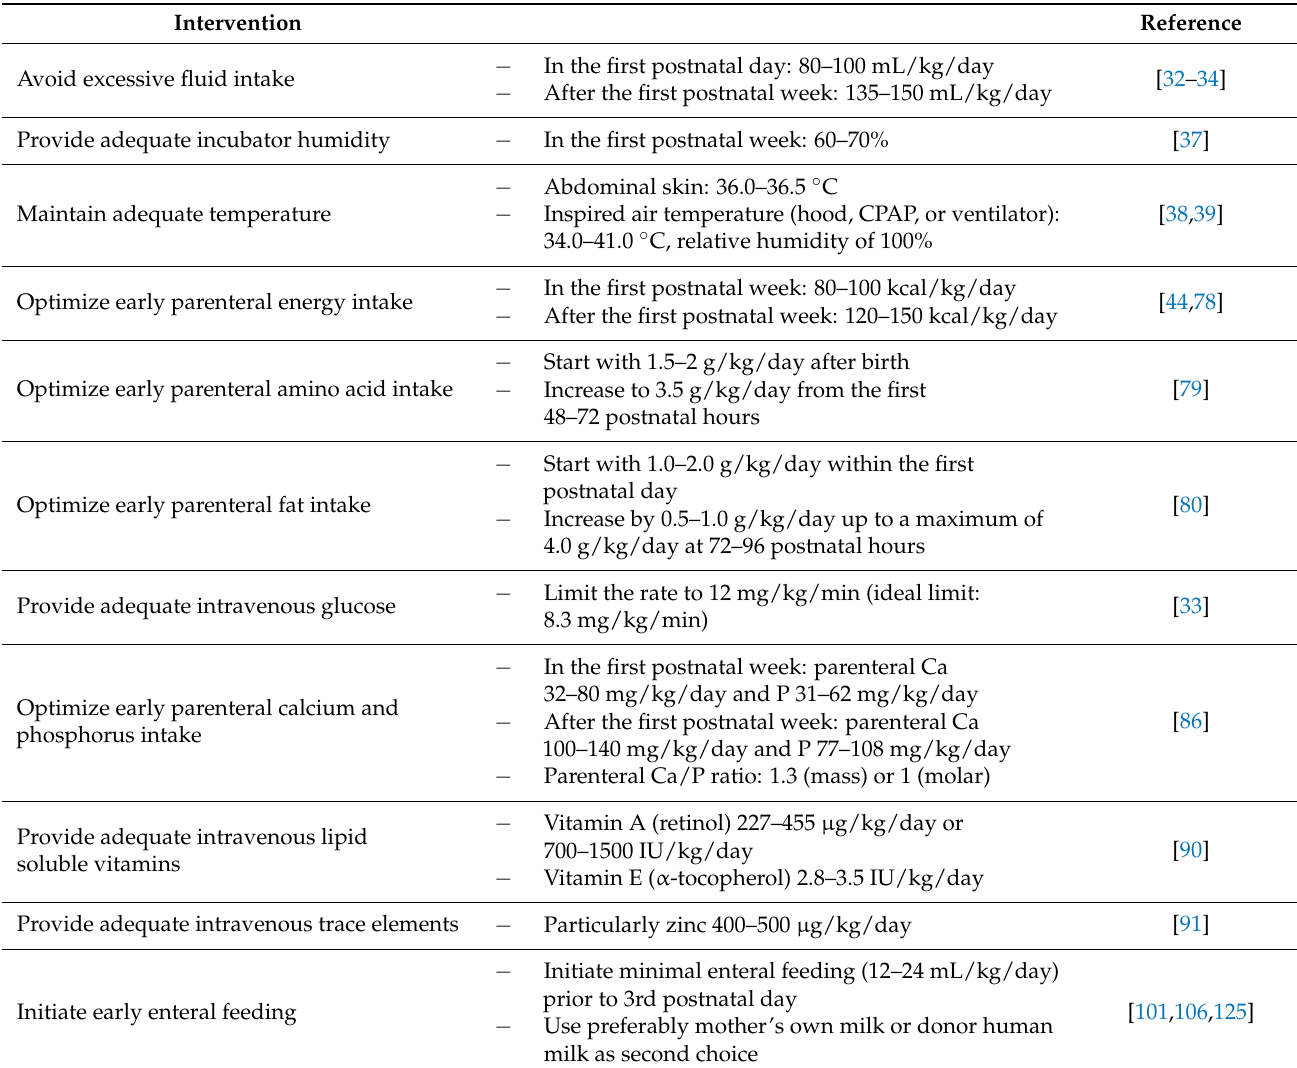
Table 1. Preventive nutritional approach in infants at high risk of